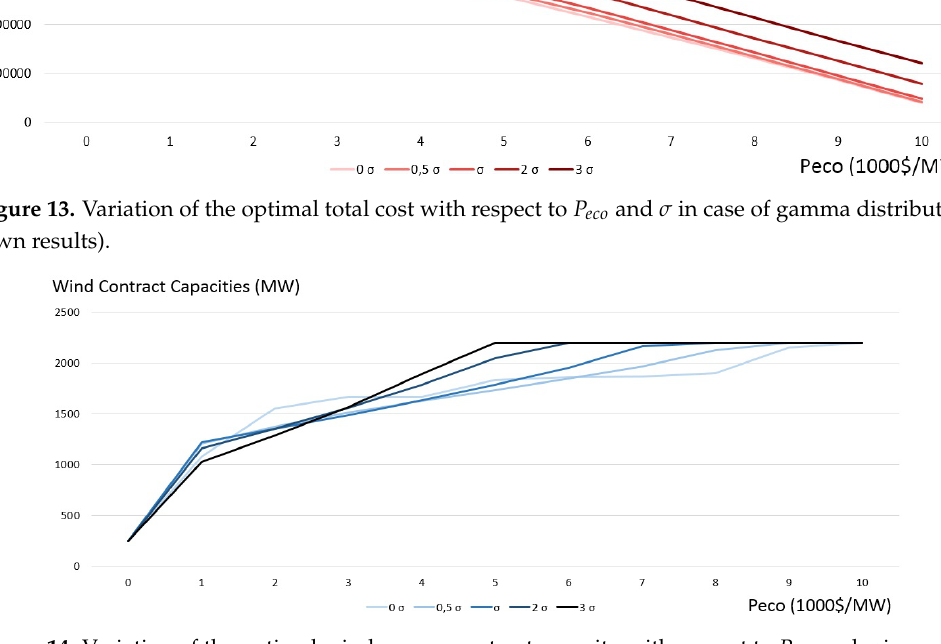
Figure 14. Variation of the optimal wind energy contract capacity with respect to P eco and σ in case of log-normal distribution (own results).